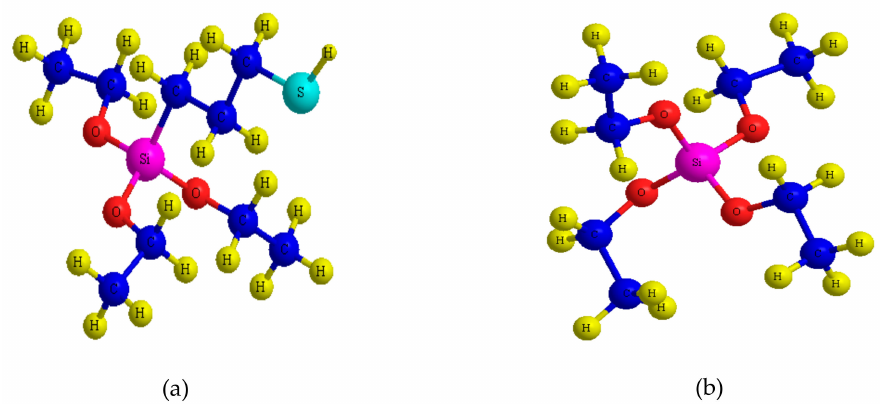
Figure 2. Molecular structures of the organo-alkoxy-silane: ( a ) 3-mercapto-propyl-triethoxyl-silane (MPTES); ( b ) tetraethyl orthosilicate